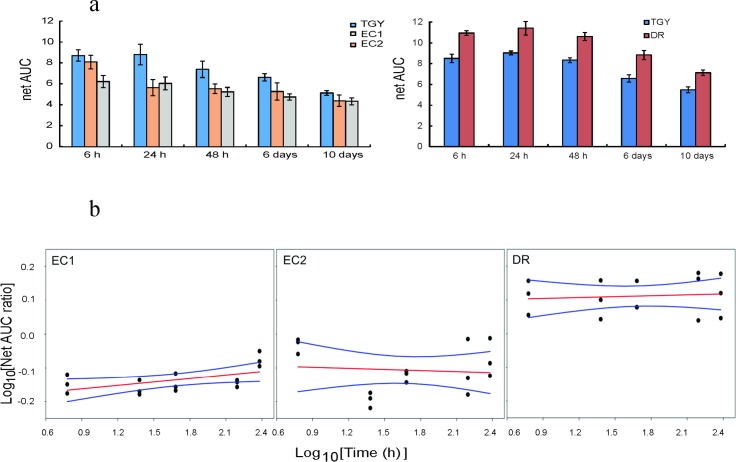
ORAC of TGY harvested with or without bacterial growth.a: The net AUC (net area under the fluorescence decay curve) is an integrative value of total fluorescence during antioxidant reaction in the presence of the indicated sample. b: Linear regression for log-transformed ratios of net AUC for samples with indicated bacteria to samples without bacteria, vs. log-transformed time. Red lines = regression best fits, blue lines = 95% confidence intervals. Y-axis values >0 suggest that the indicated microorganisms increased the ORAC of the medium; values <0 suggest the opposite—microorganisms decreased the ORAC.